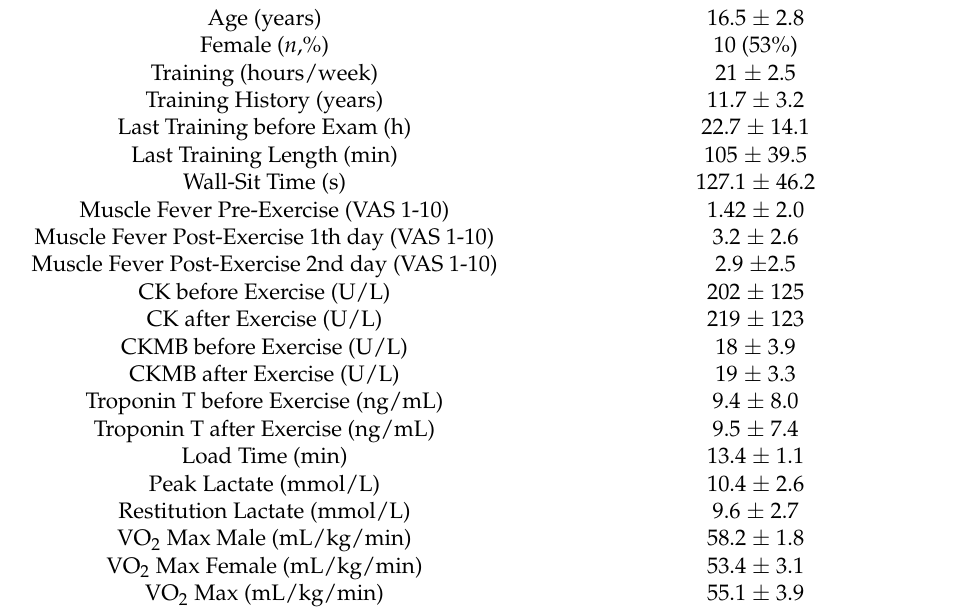
Table 2. Baseline characteristics of the 19 athletes involved in the